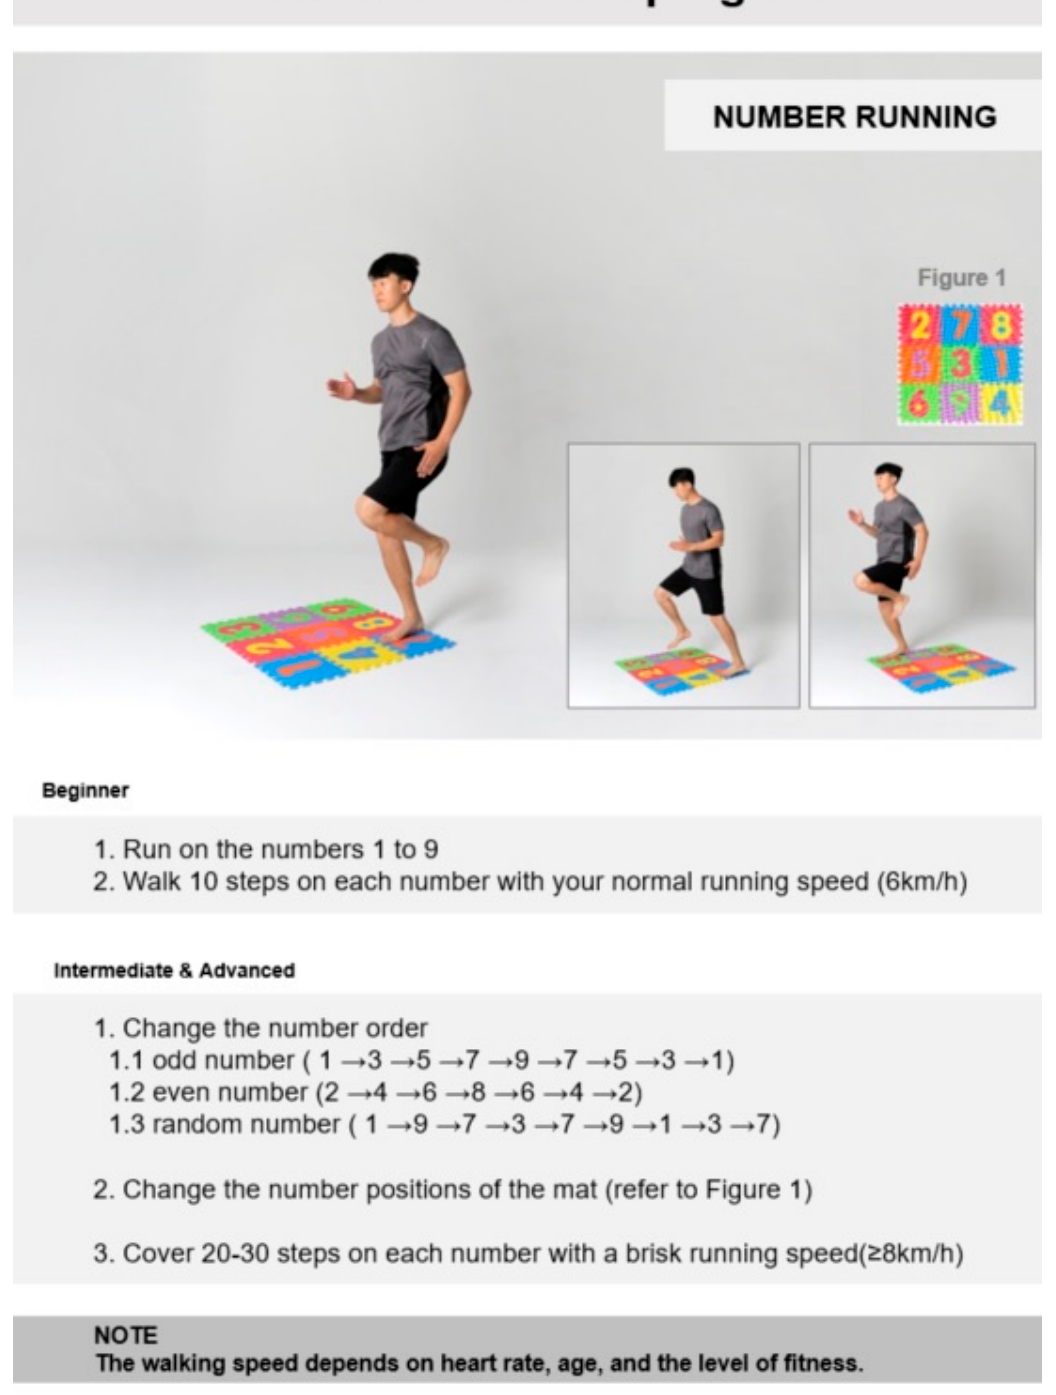
Figure A2. Detailed description and components of each movement in the “Number running” aerobic exercise.